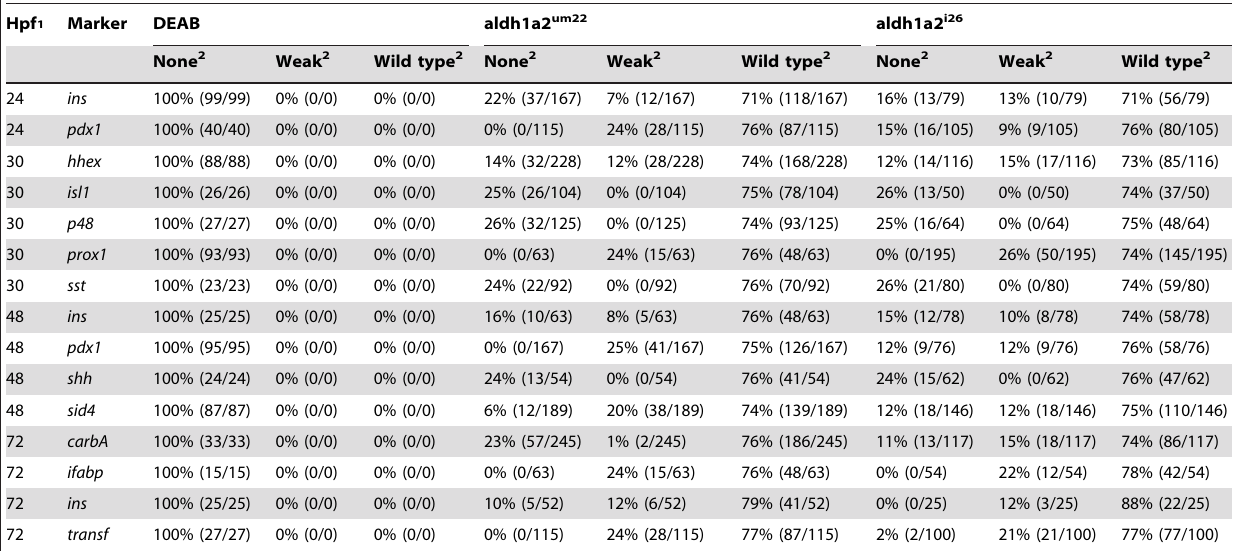
Table 2. DEAB, aldh1a2 um22 , and aldh1a2 i26 in situ